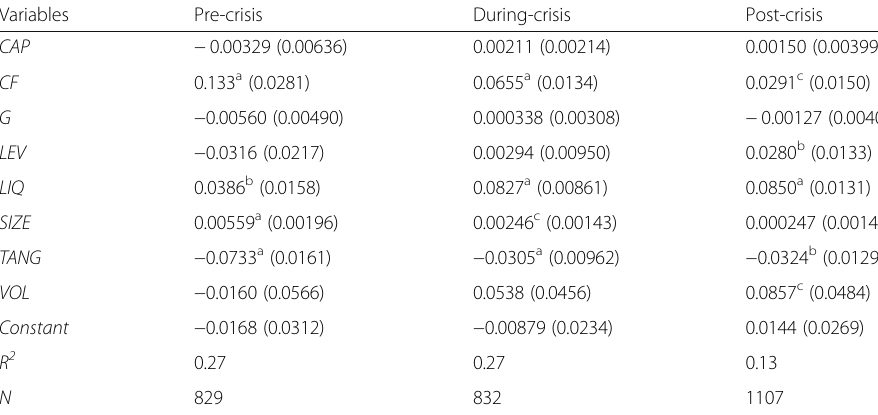
Table 5 Robustness test using alternative proxy of cash